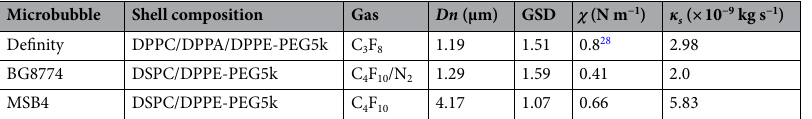
Table 1. Physicochemical and viscoelastic shell properties of the microbubble formulations. Dn mean microbubble diameter, GSD geometric standard deviation, χ shell stiffness, κ s shell viscosity.